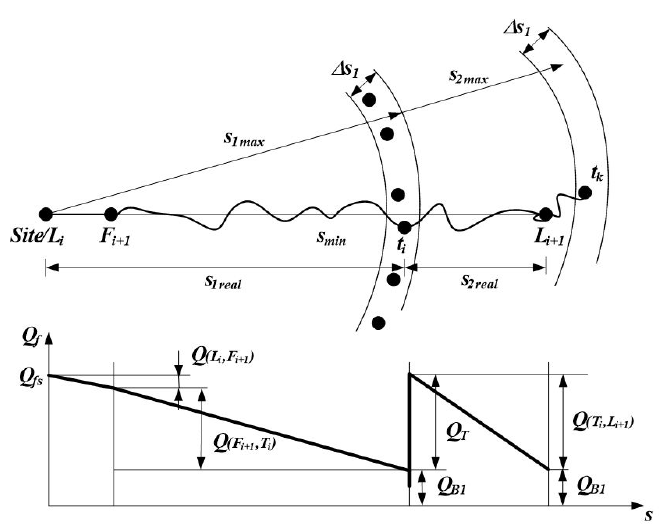
Figure 2. Determination of the potential fueling stations and the fuel level changes on the transport